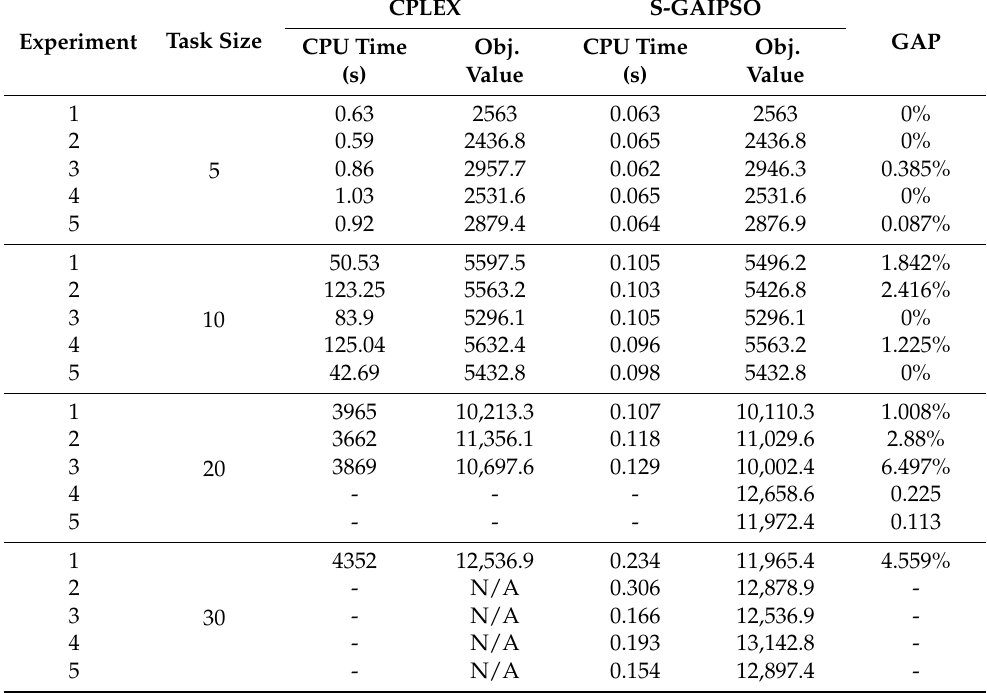
Table 3. Result comparison of CPLEX and